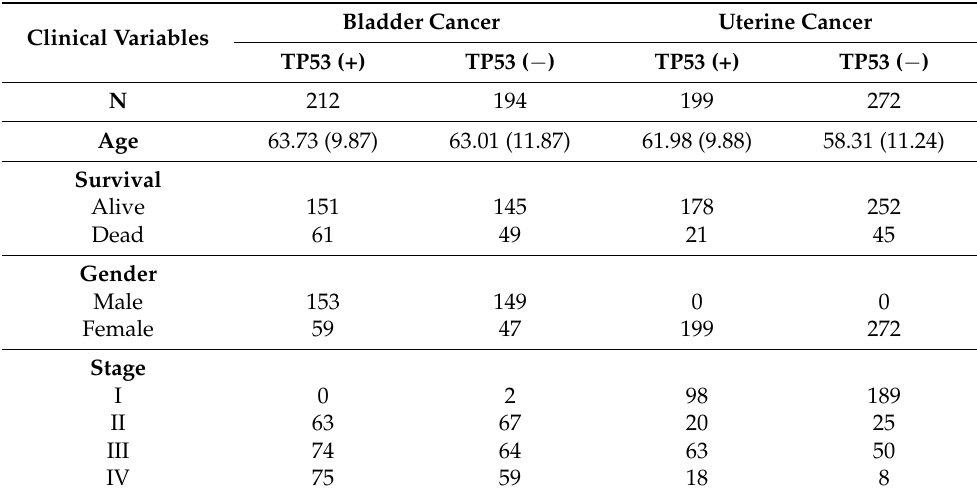
Table 1. Patient characteristics of TCGA validation dataset, bladder urothelial carcinoma and uterine corpus endometrial